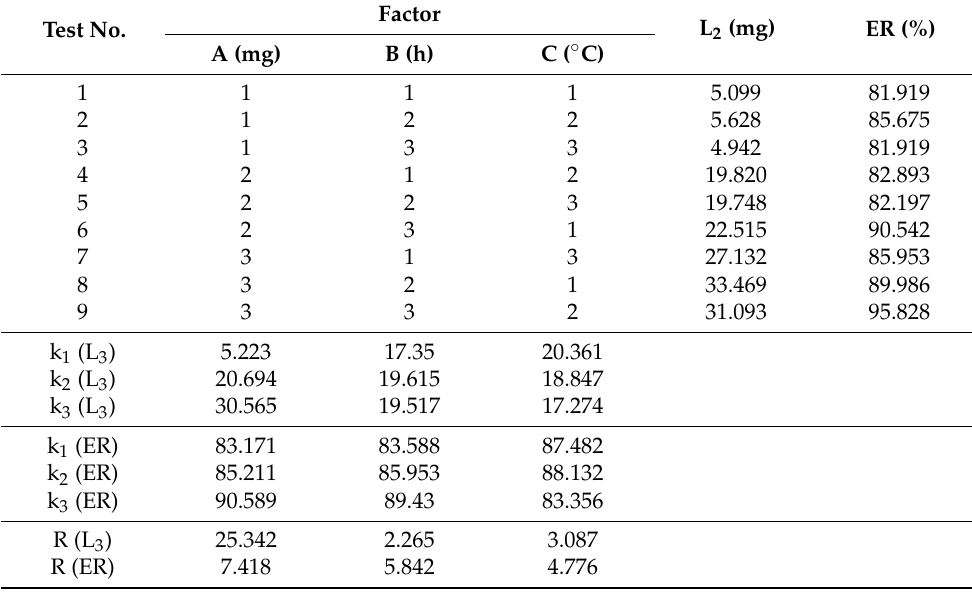
Table 1. The results of orthogonal test. Test